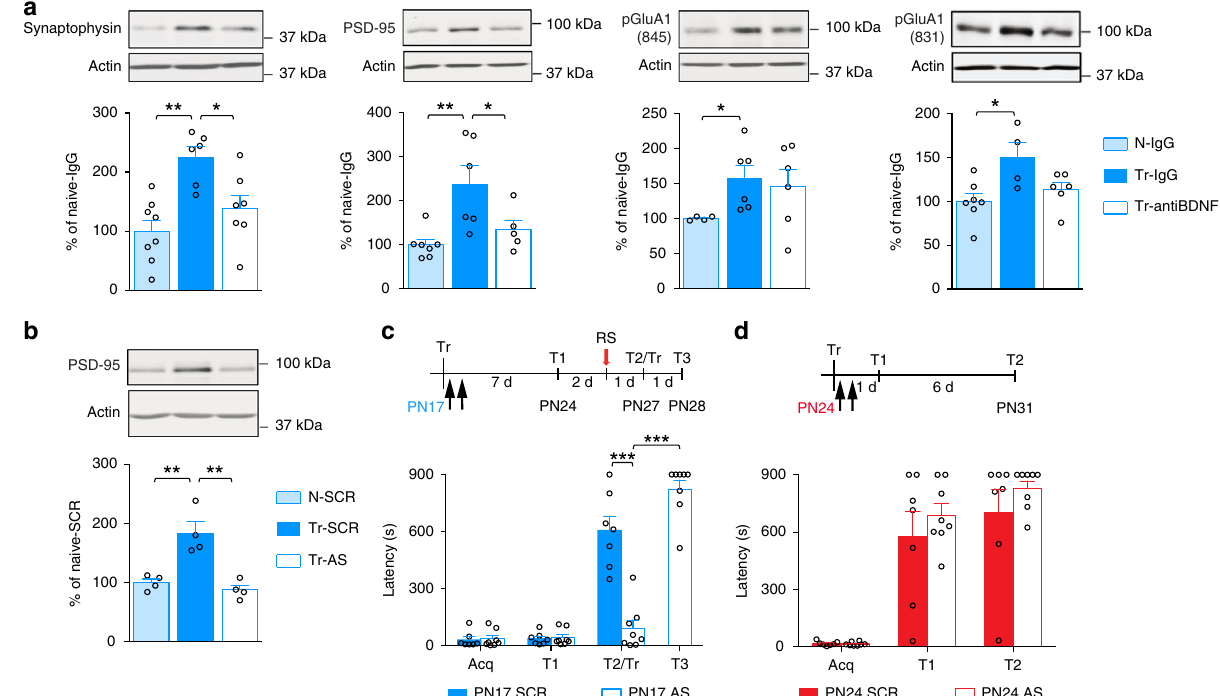
Fig. 2 Learning-induced de novo PSD-95 synthesis is required for infantile memory formation. a Examples and densitometric western blot analyses of synaptophysin, PSD-95, pGluA1(845), and pGluA1(831) carried out with dHC whole-protein extracts obtained from PN17 naive (N) and trained (Tr)